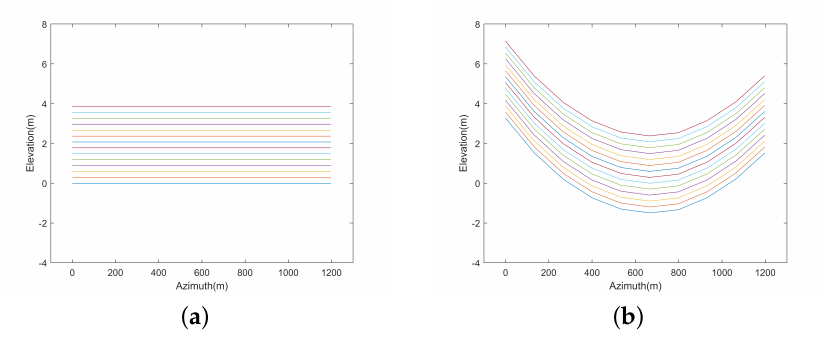
Figure 8. X-band trajectory. ( a ) Ideal linear trajectory. ( b ) Non-ideal linear trajectory. Figure 8 indicates that the baseline lengths of the ideal and non-ideal linear trajectories are approximately 4 m and 8 m, respectively. From Equation (21) and Table 1, the